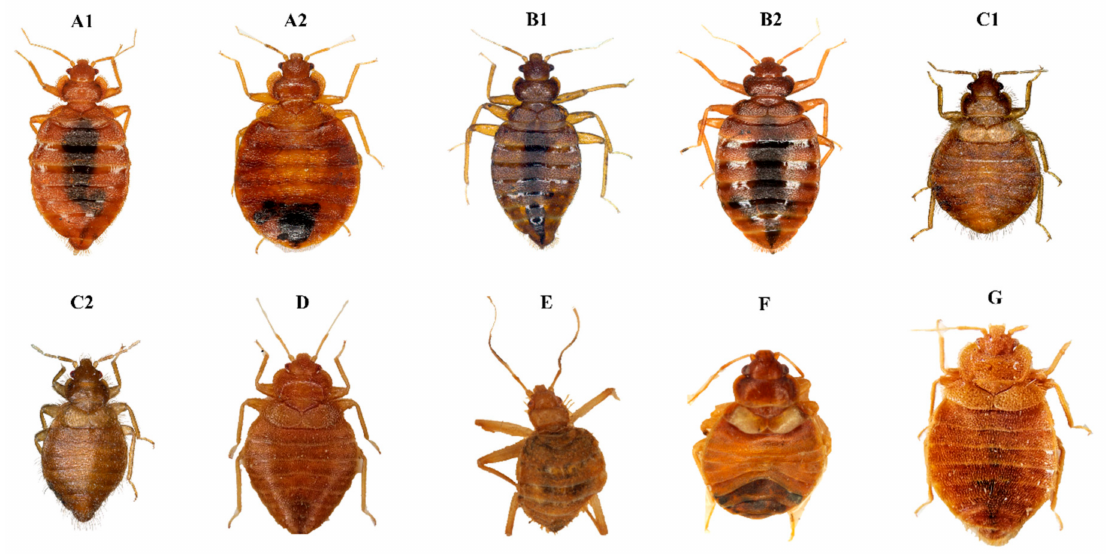
Figure 1. Habitus of main important cimicids: C. lectularius male ( A1 ) and female ( A2 ); C. hemipterus male ( B1 ) and female ( B2 ); C. hirundinis female ( C1 ), male ( C2 ); C. pipistrelli female ( D ); C. columbarius female ( G ); L. boueti not specified ( E ); H. inodorus female ( F